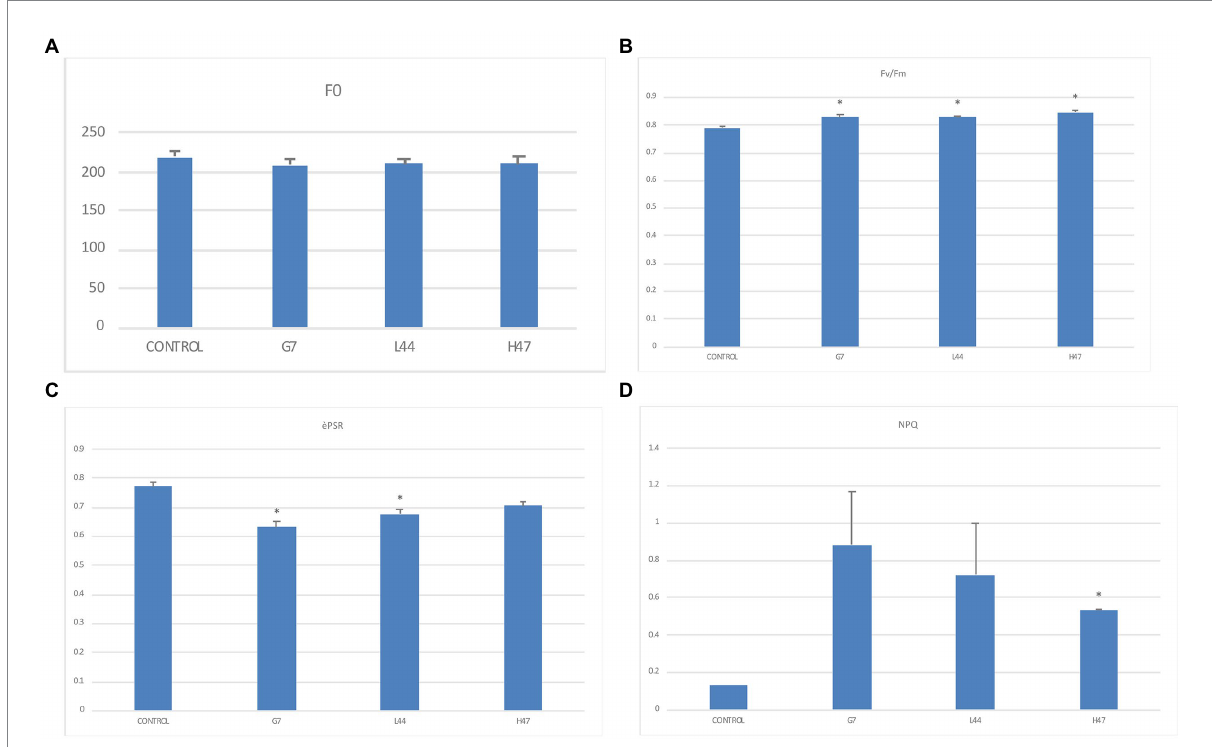
FIGURE 1 Photosynthetic parameters related to photosystems and light reactions in inoculated and non-inoculated controls. (A) Minimal fluorescence after 20-min dark-adaptation (F o ). (B) Maximal PSII quantum yield (Fv/Fm), (C) effective PSII quantum yield ( Φ PSII), and (D) non-photochemical quenching coefficient (NPQ) measured in olive tree plants. For each treatment and parameter average value ±SE value ( n = 6) is